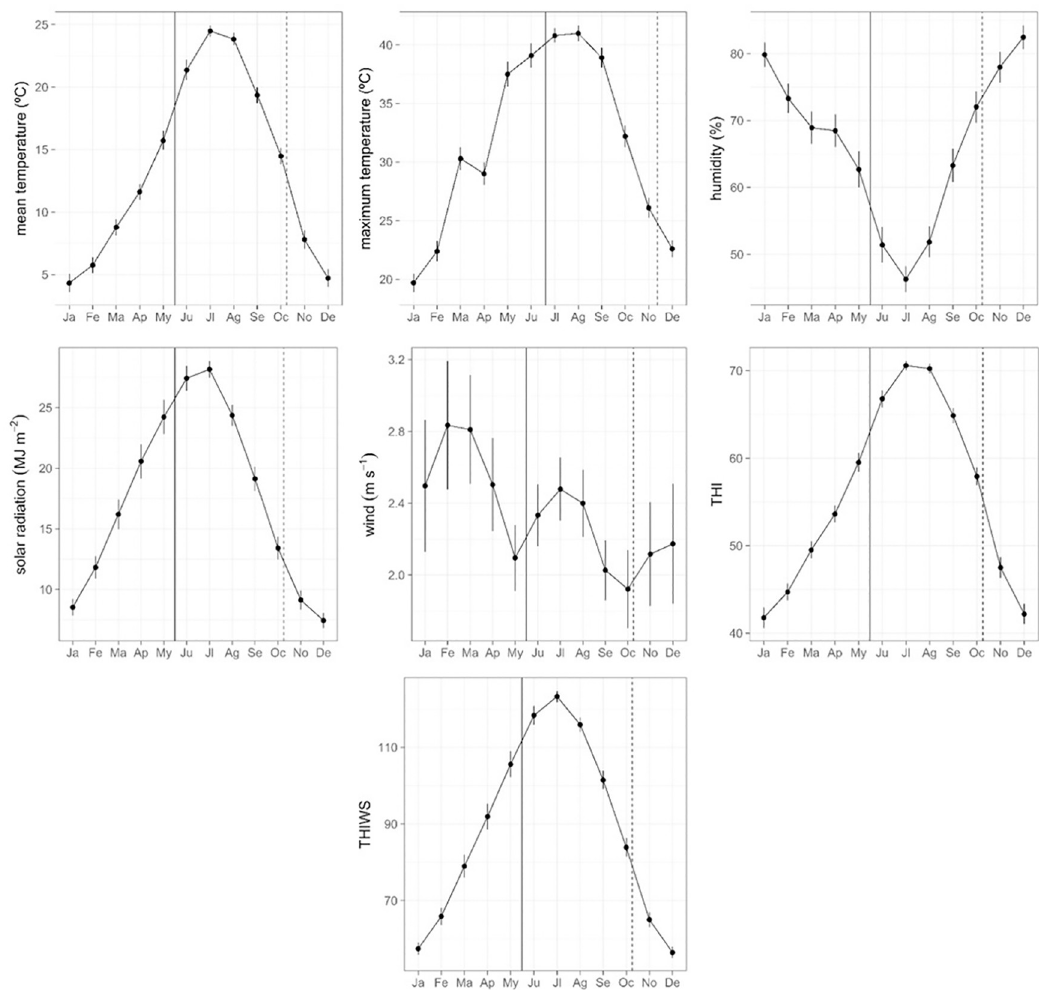
Fig 1. From left to right top to bottom: Monthly mean and standard errors of mean and maximum daily air temperature, relative air humidity, accumulated daily solar radiation, mean wind speed and two indices of heat stress (THI, THIWS) in the study area (period